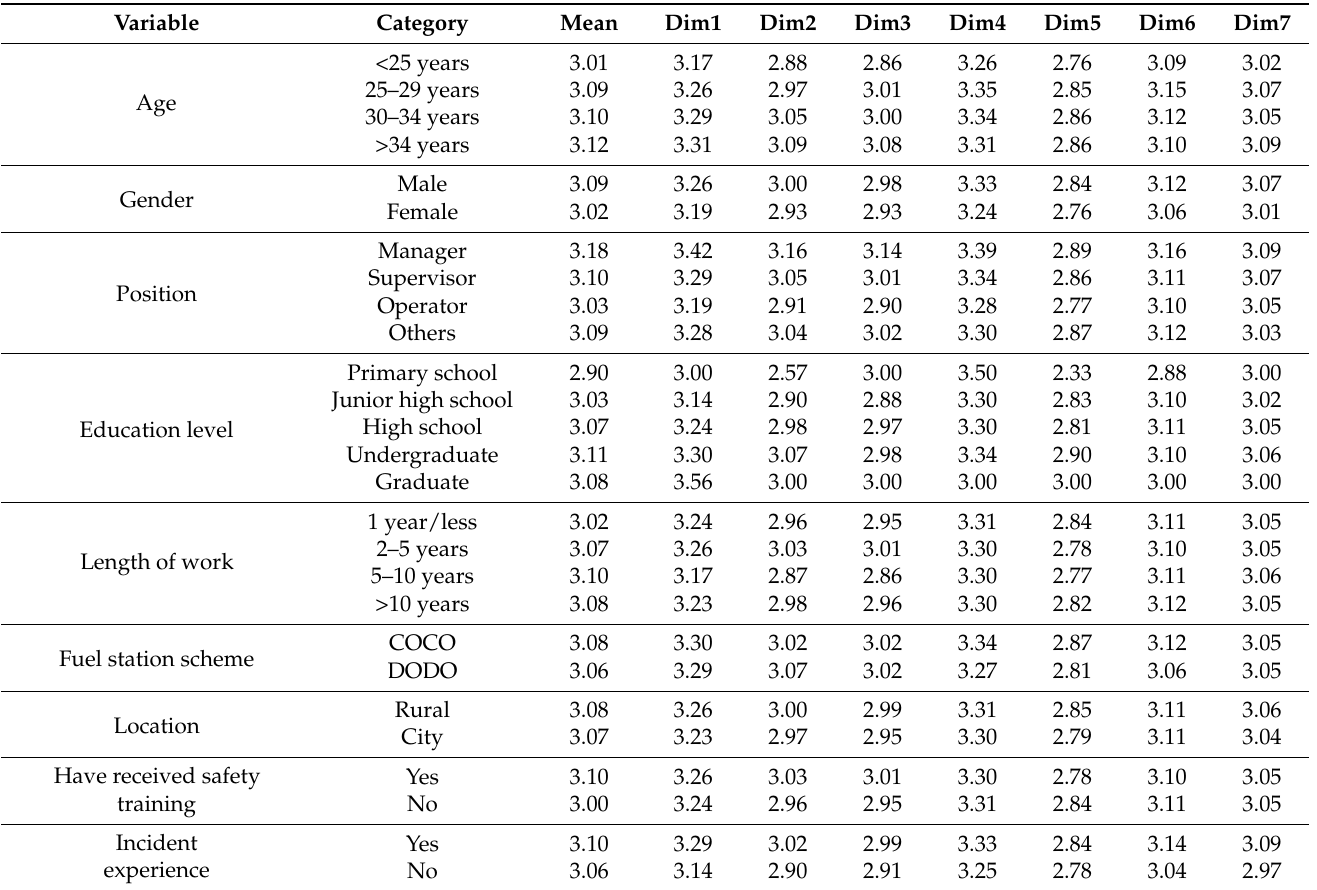
Table 5. Safety climate scores (scale 1 to 4) filtered by respondents’ background